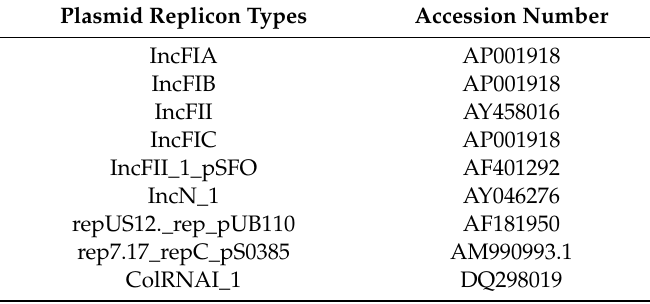
Table 2. List of prevalent plasmid replicon types identified in all the poultry metagenomic